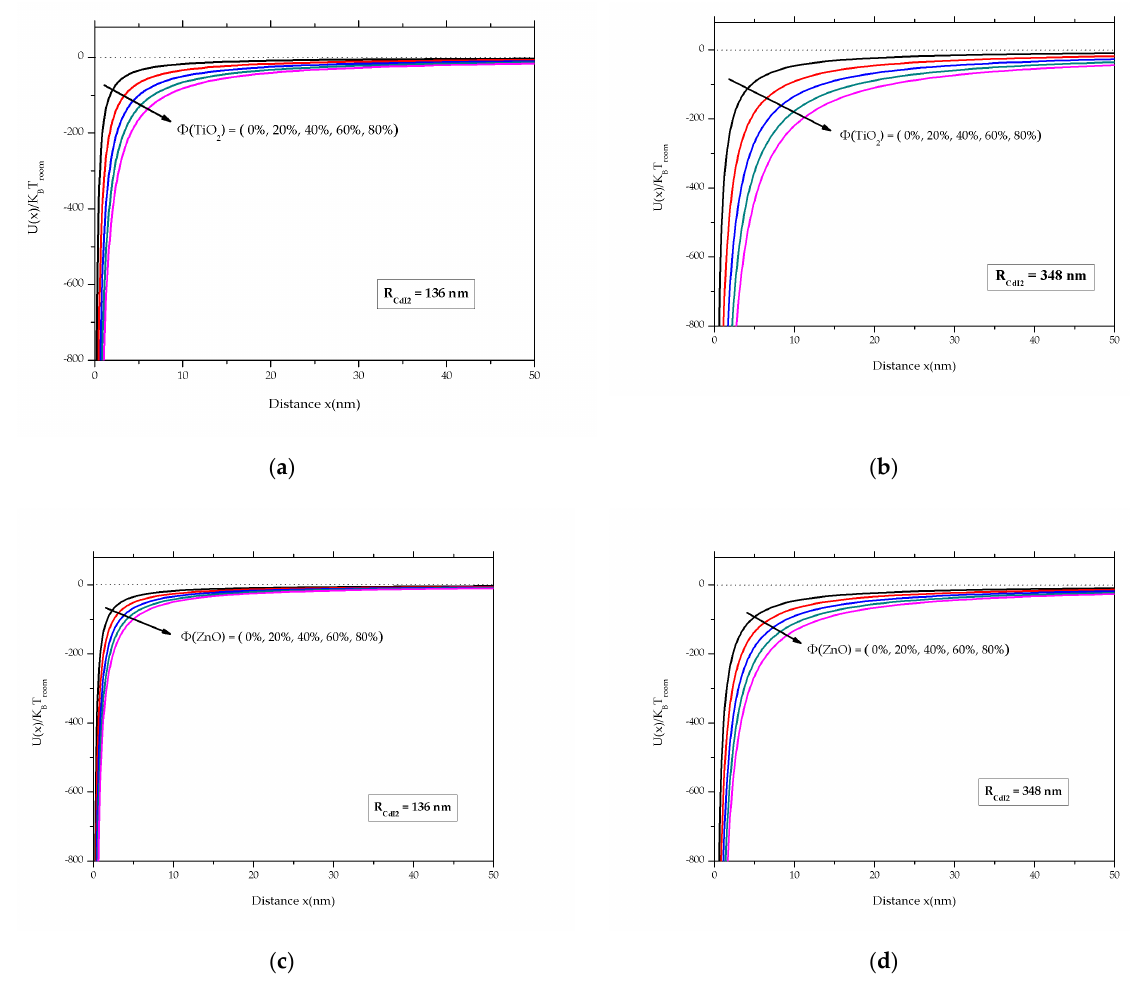
Figure 9. VdW energy U of CdI 2 ‐ PANI/NPs across water medium as function of separating distance x and for the various volume fraction Φ of NPs: ( a ) PANI/TiO 2 with R c = 136 nm, ( b ) PANI/TiO 2 with R c = 348 nm, ( c ) PANI/ZnO with R c = 136 nm and ( d ) PANI/ZnO with R c = 348 nm.